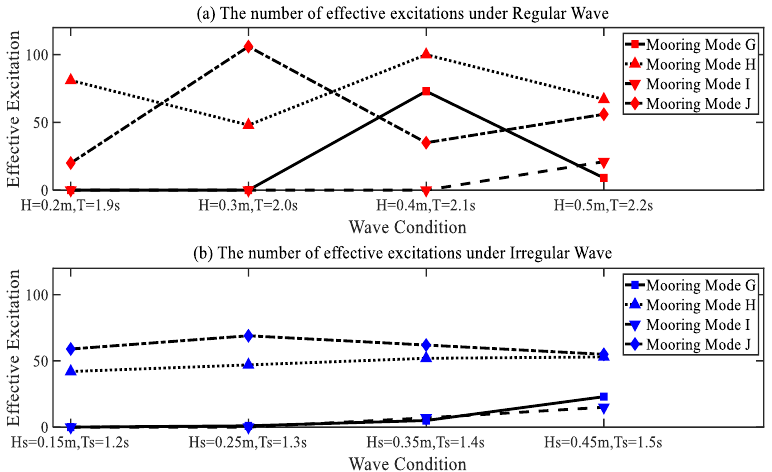
Figure 18. .The total number of effective excitations for the buoy under different wave conditions in the three-anchor line mooring mode. the three-anchor line mooring